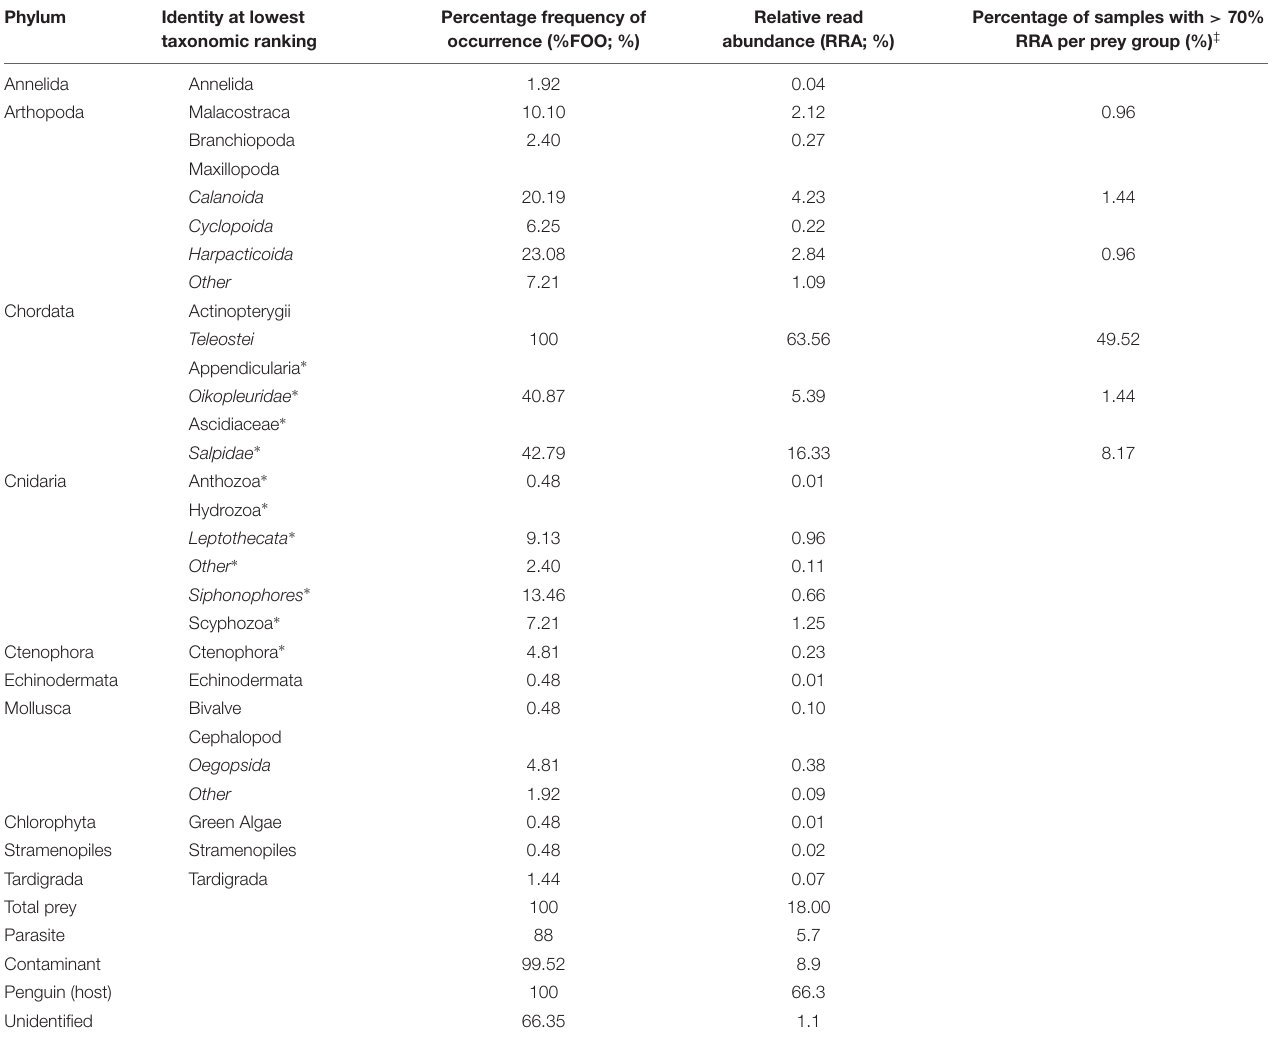
TABLE 2 | Sequences uncovered in the feces of little penguins Eudyptula minor on Phillip Island during the 2015–2016 breeding season, using the universal eukaryote primer, 18S_SSU (18S rDNA, McInnes et al., 2017a). Phylum Identity at lowest taxonomic